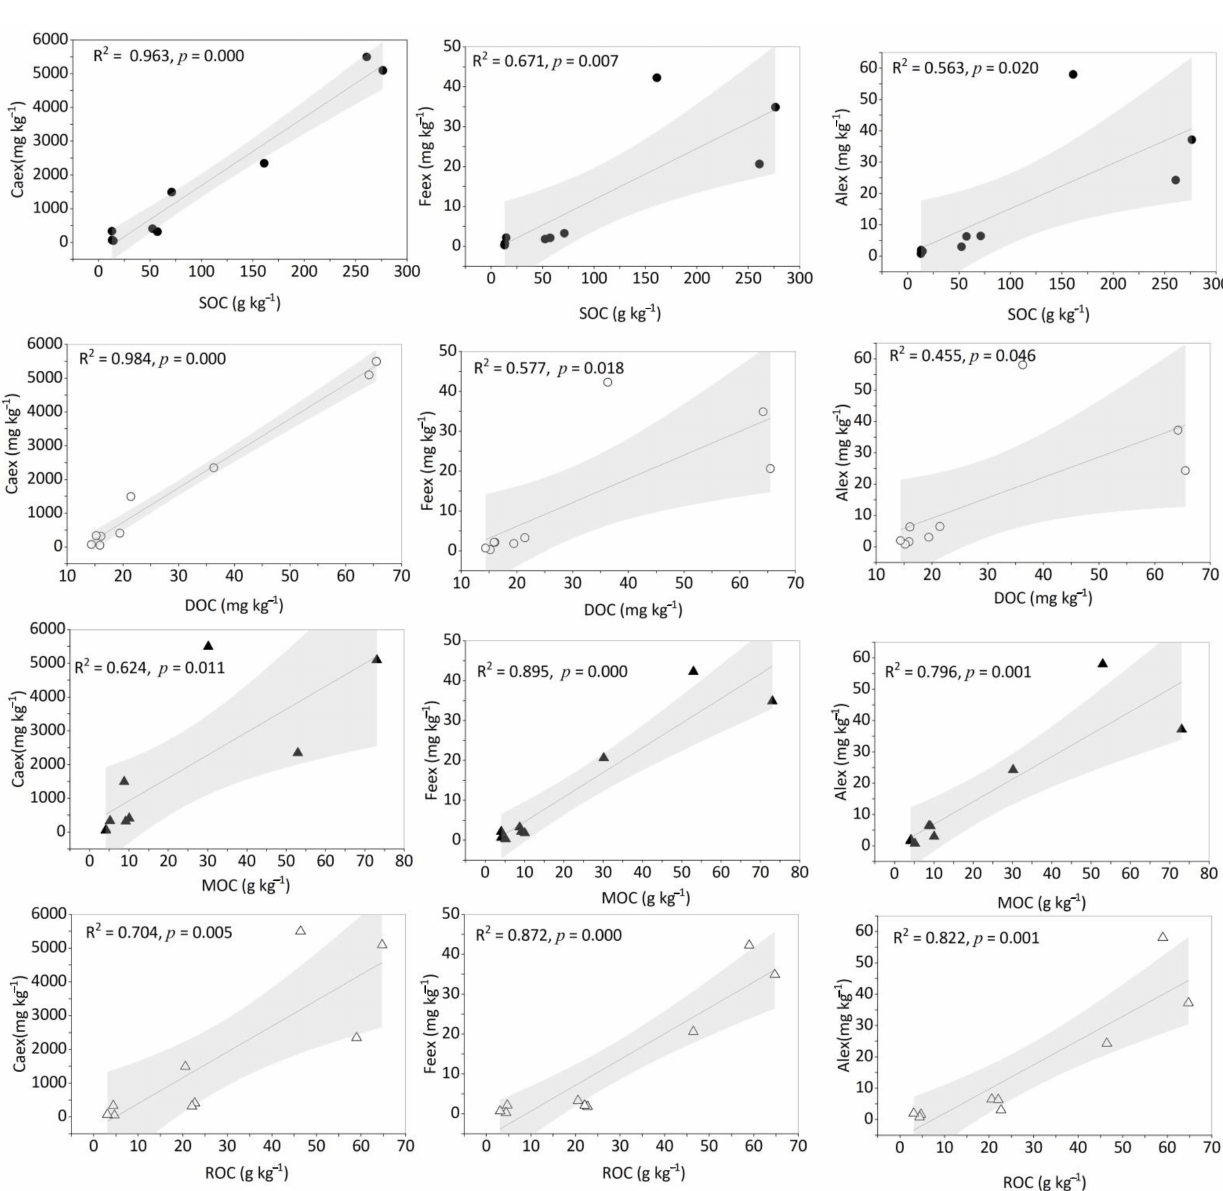
Figure 5. Correlation of fractions of SOC with base cation in the subtropical karst area of southern China. Ca ex , Fe ex , and Al ex represents exchangeable Ca, Fe, and Al,